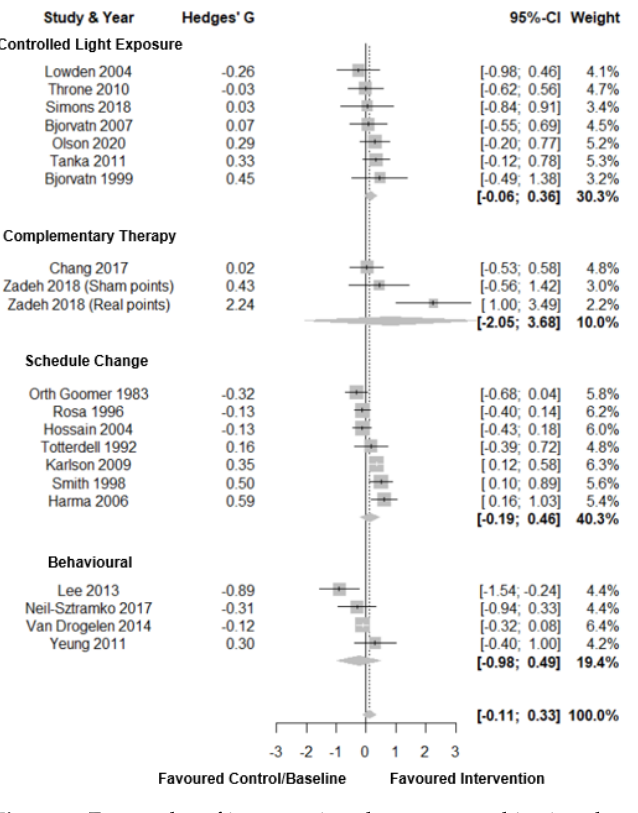
Figure 8. Forest plot of interventions by type on subjective sleep quality. Note. Interventions with multiple conditions are denoted within brackets.